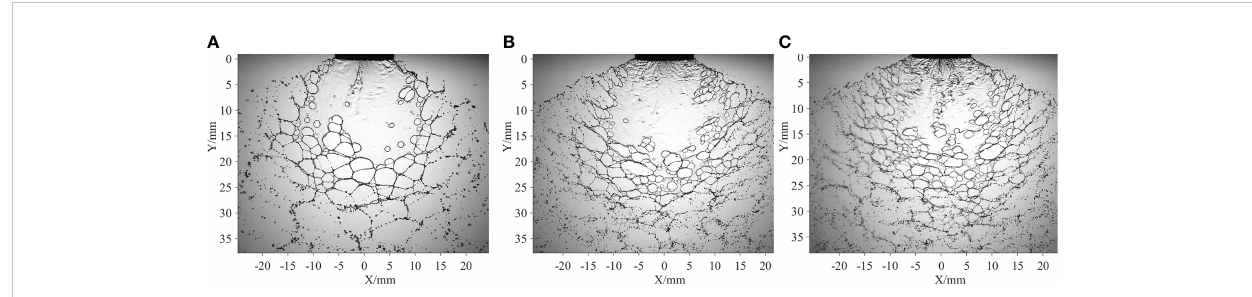
FIGURE 7 Spray sheets at different spray pressures. The spray sheets are produced by the ST-110-03 nozzle, and the volumetric concentration of the oil-based emulsion is 0.1%. (A) P =0.1 MPa (B) P =0.3 MPa (C) P =0.5 MPa.